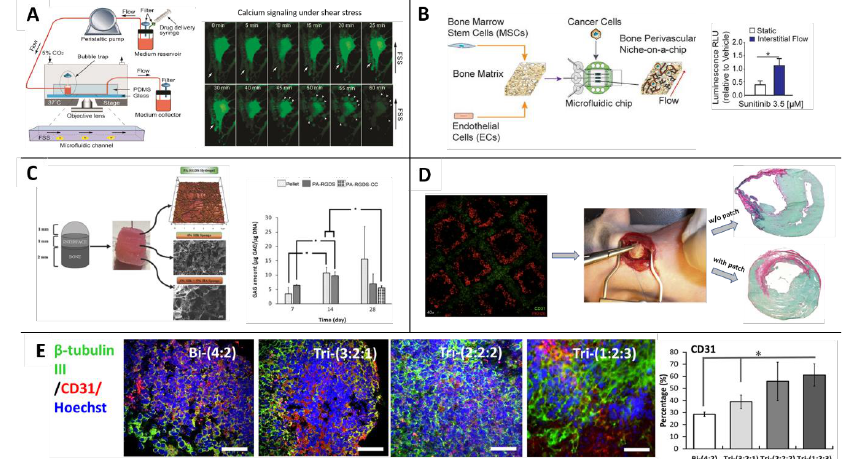
Figure 4. Functional readout of different in vitro models with MSCs. ( A ) Response of MSCs to fluid shear stress shown by calcium signaling in a microfluidic device (from Reference [119]); ( B ) Metastatic colonization on a Bone Marrow-on-a-Chip platform. Treating with a drug (sunitinib) under flow decreased the sensitivity of the treatment to known in vivo values (adapted from Reference [122]); ( C ) Osteochondral bi-layered scaffold model shown increased growth of cells over time (adapted from Reference [129]); ( D ) Bioprinted MSCs/endothelial cells (ECs) cardiac patch improves the regeneration of the heart’s wall after an infract (adapted from Reference [180]). ( E ) Neurovascular spheroids with different neuronal progenitor cells: EC: MSC ratios. Increasing in MSCs amount leads to enhance expression of CD31, which is known as a vascular marker (adapted from Reference